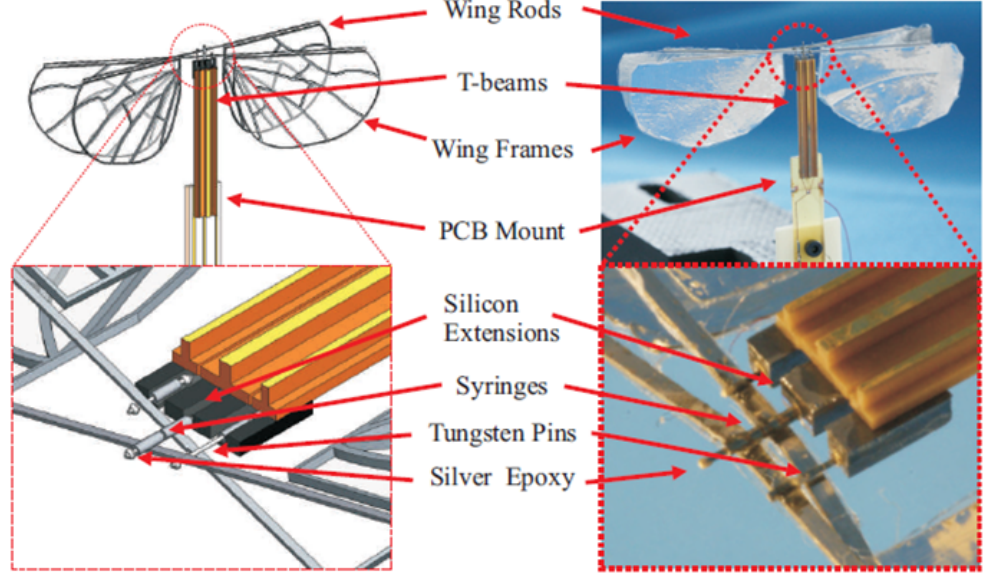
Figure 7. Conceptual design of the Penn State flapping system ( left ), four winged piezoelectric flapping system device ( right )